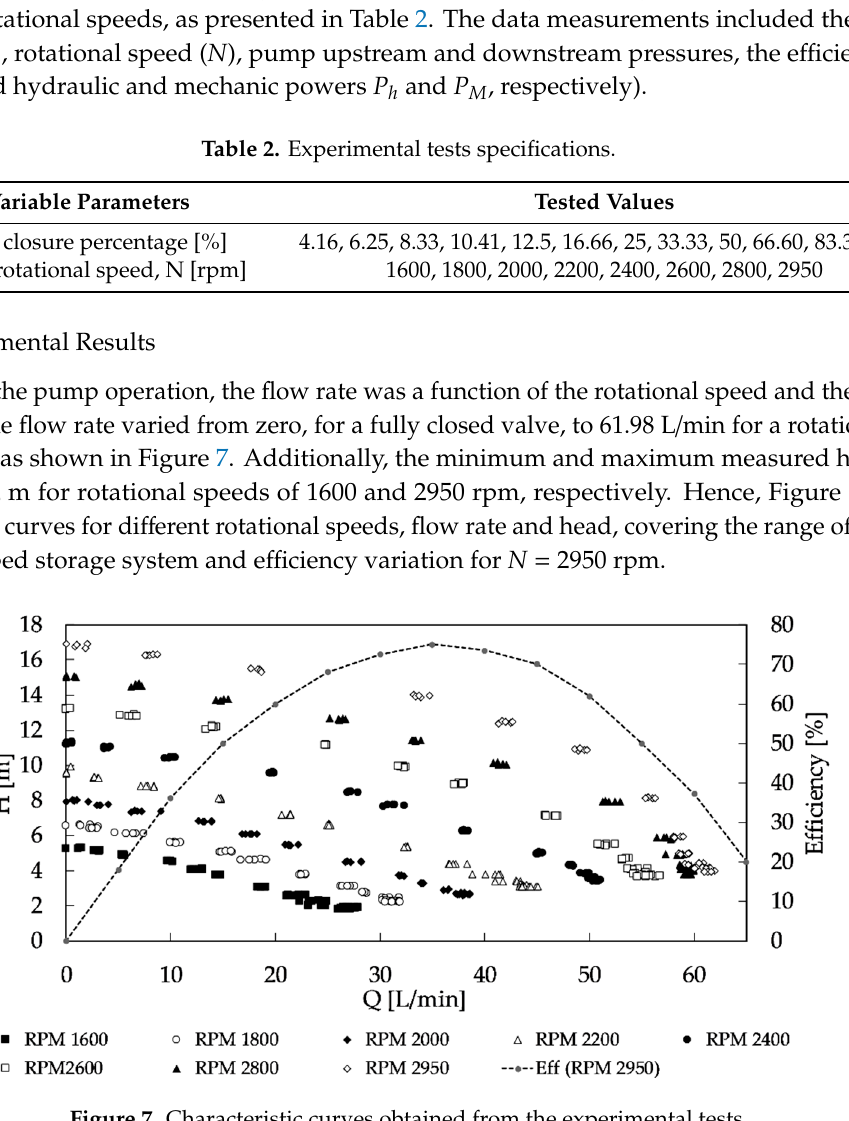
Figure 7. Characteristic curves obtained from the experimental tests.